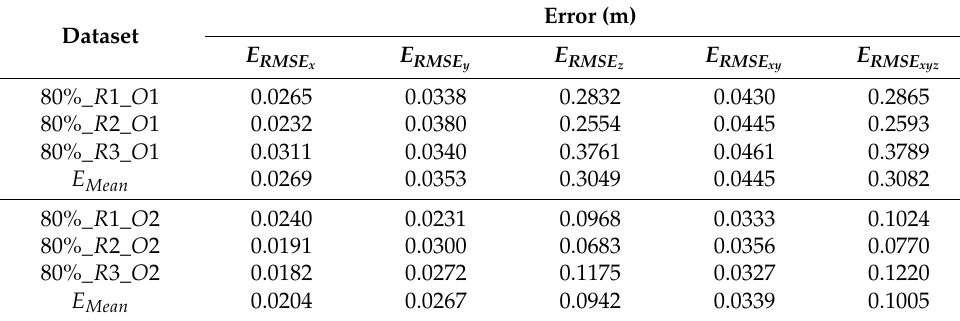
Table 4. 3D scenes accuracy assessment results for different datasets.